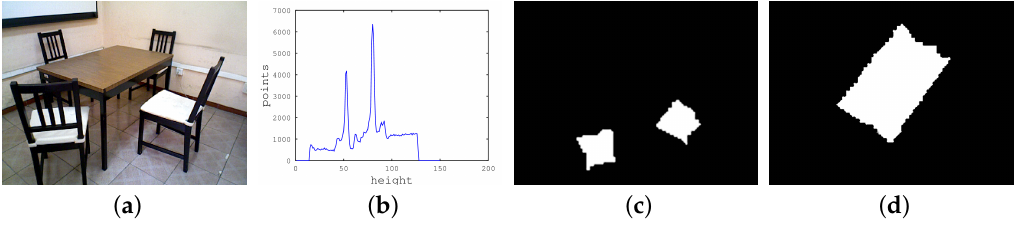
Figure 7. Example of a height histogram and the objects segmentation. In ( a ), the RGB from the scene, in ( b ), the height histogram, and ( c , d ) show the projections for each peak found on the